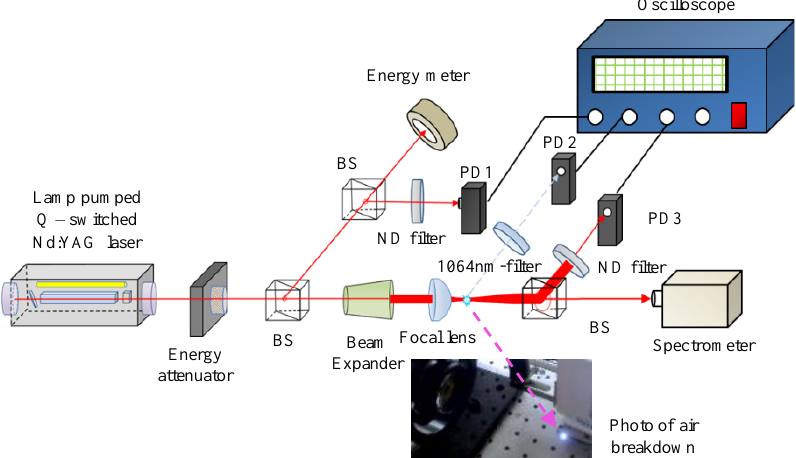
Figure 1. Schematic diagram of experimental setup and the photo of air breakdown. BS: beam splitter; PD: photodetector.